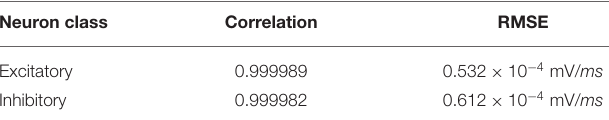
TABLE 4 | Correlation and RMSE for different neuron classes.